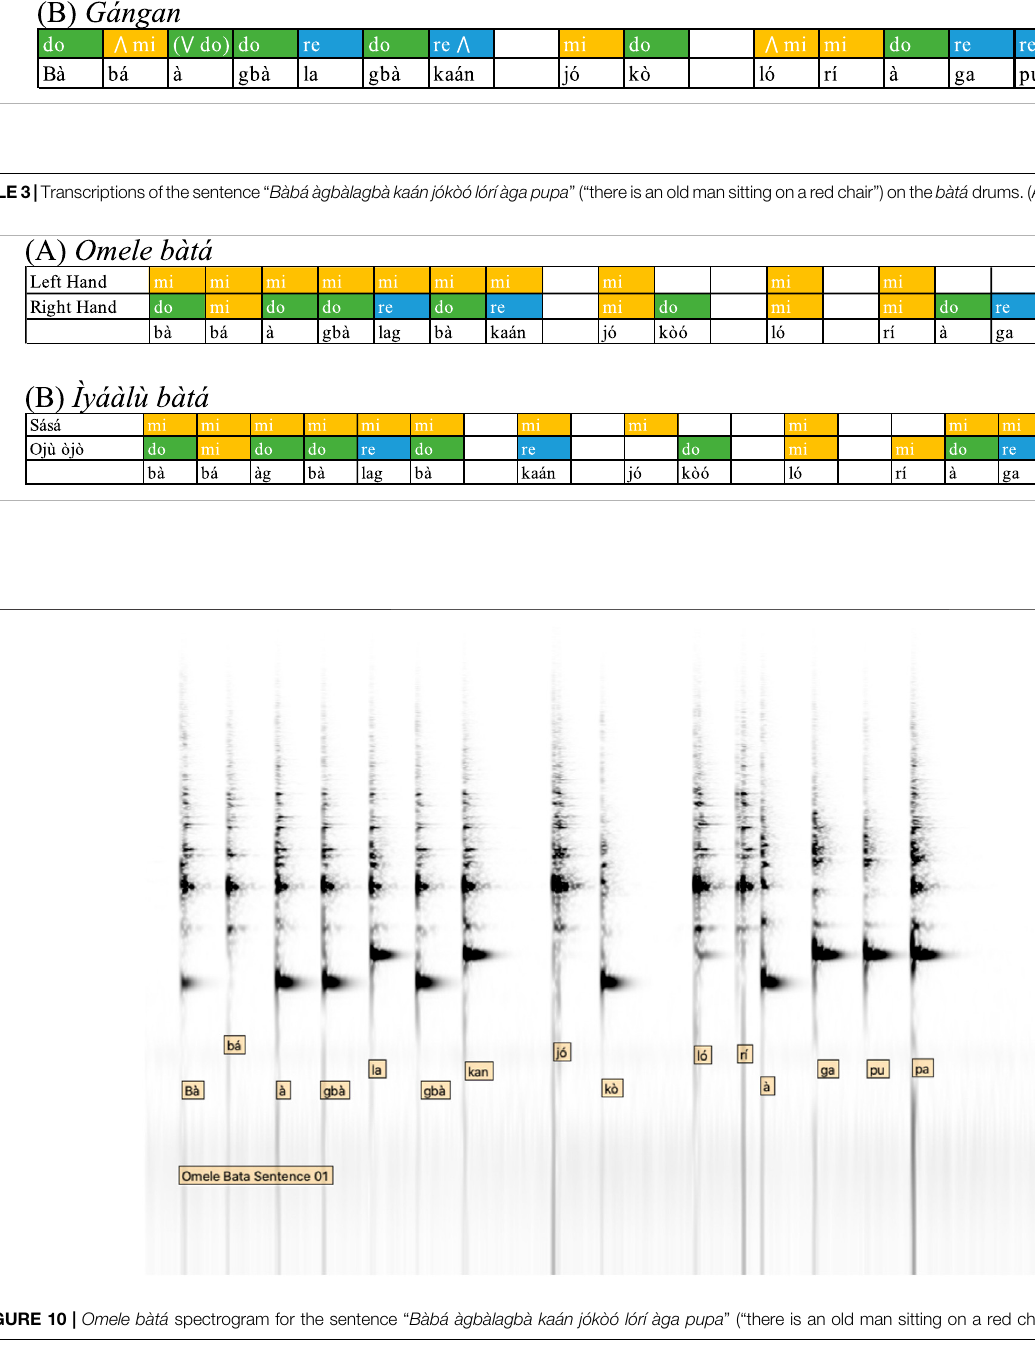
Frontiers in Communication |